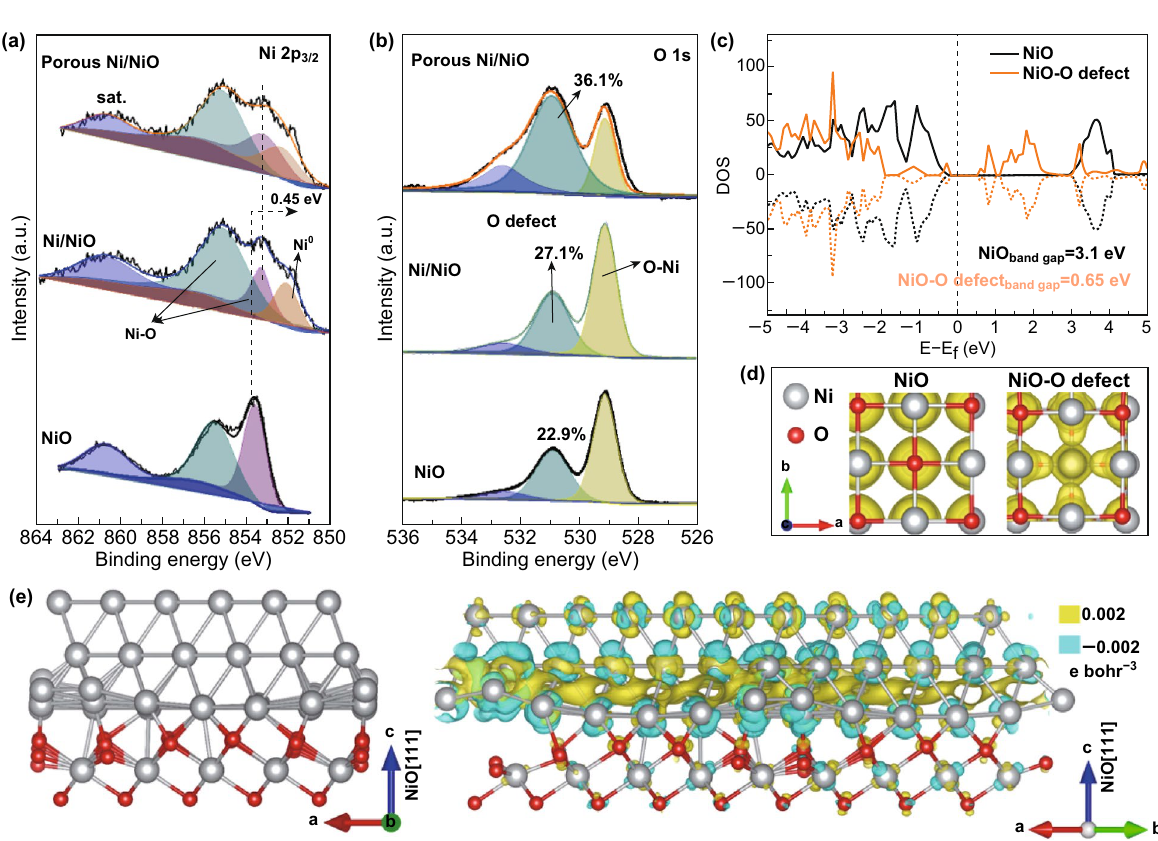
Fig. 2 a High-resolution Ni 2p and b O 2 p XPS spectra for NiO, Ni/NiO, and porous Ni/NiO nanosheets. c Calculated DOS results for NiO with and without O-deficiencies. d Calculated partial charge density of NiO with and without O-deficiencies (the isosurface value is 0.001 e/ bohr 3 ). e Structure of the interface formed between Ni (111) and Ni-terminated NiO (111) slabs and the corresponding calculated charge density difference, where yellow and blue represent electron